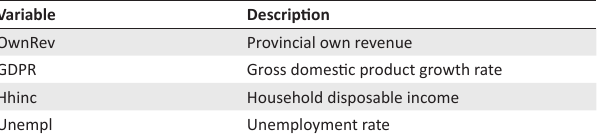
TABLE 1: Data description.